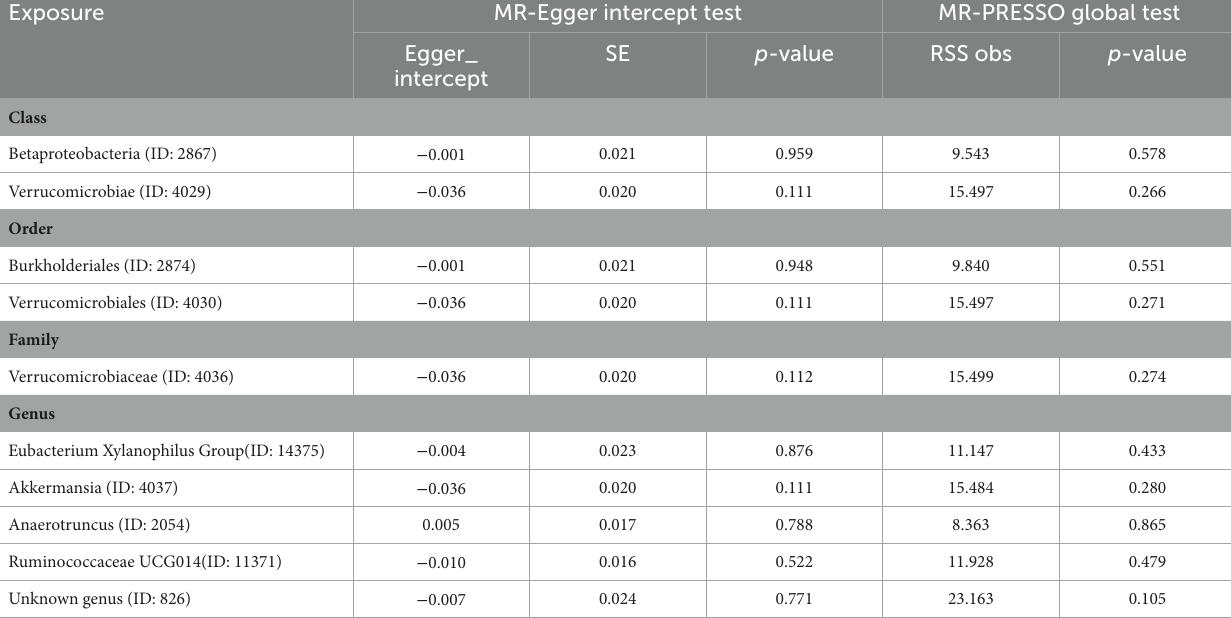
TABLE 2 Horizontal pleiotropy analysis for IVs of 10 GM taxa associated with epilepsy. Exposure MR-Egger intercept test MR-PRESSO global test Egger_ SE p -value RSS obs p intercept